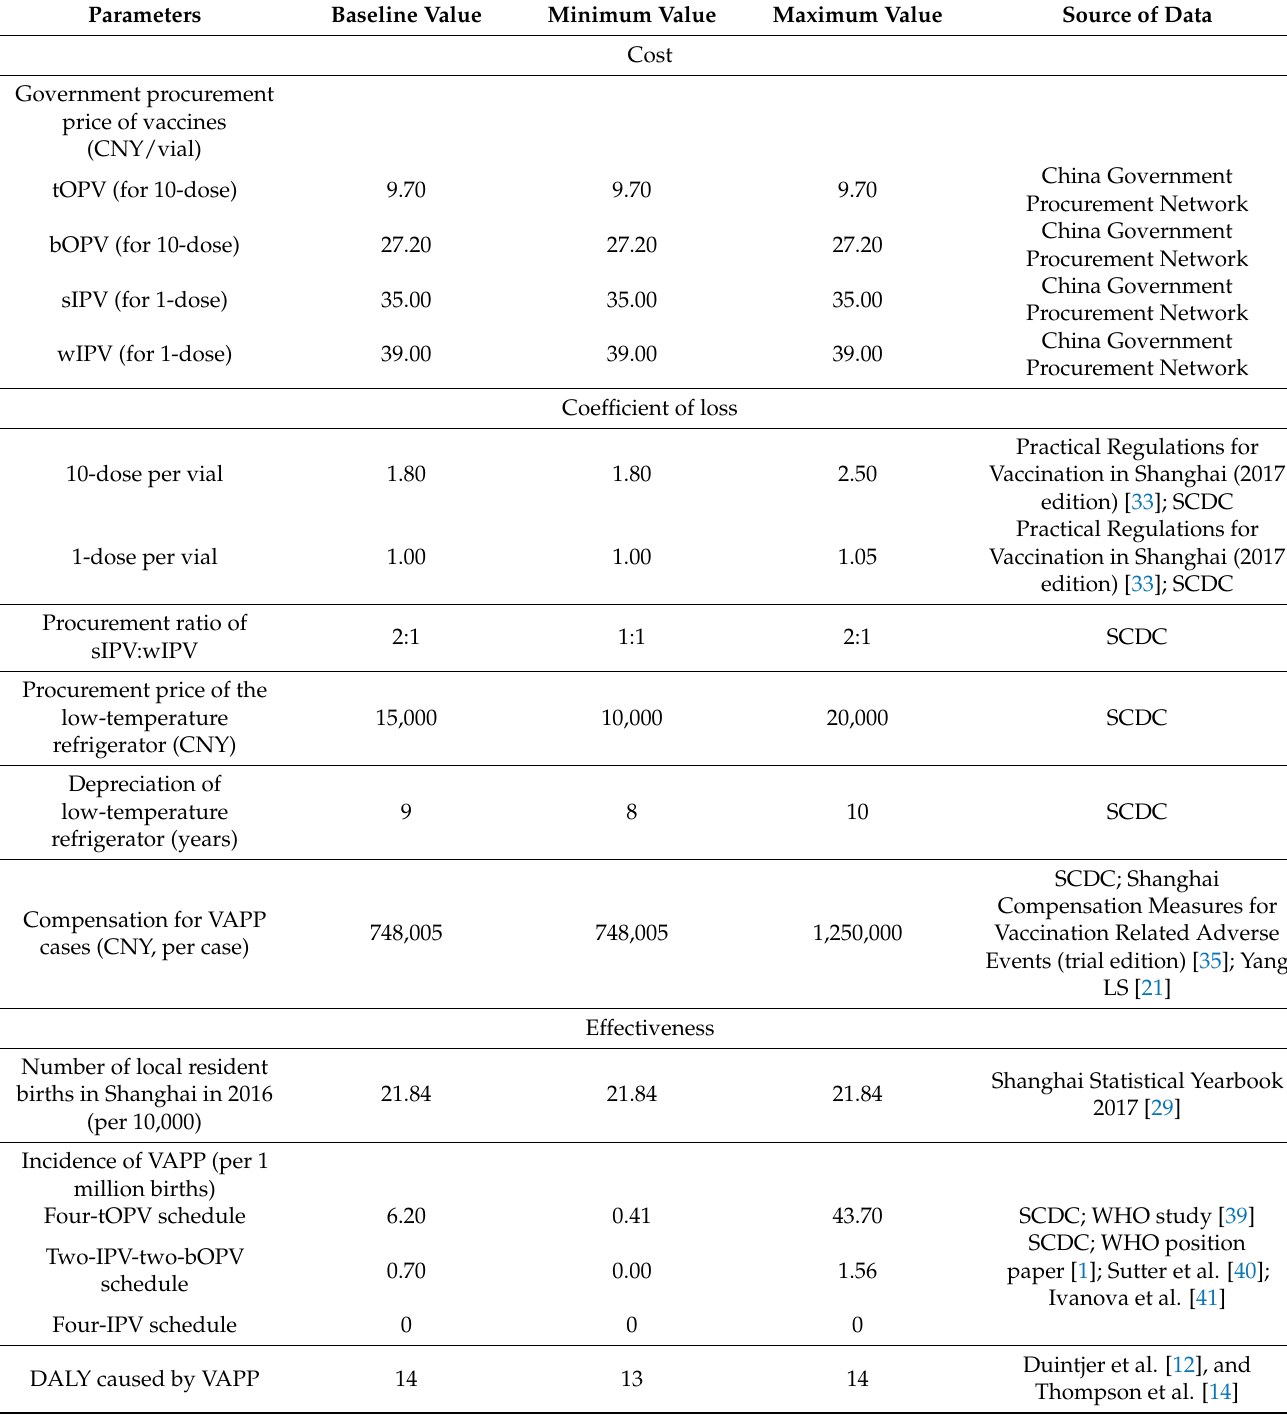
Table 1. Parameters for estimation of cost and effectiveness in the decision tree